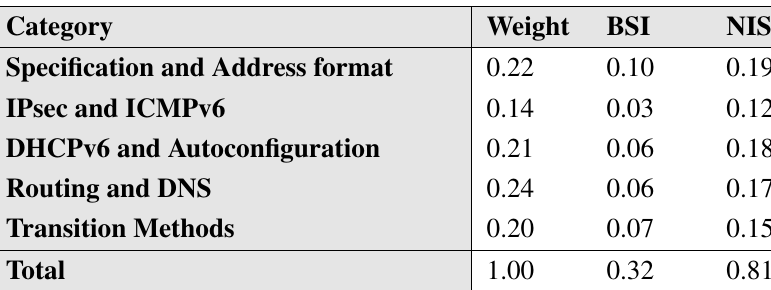
Table 9. Comparison of weighted